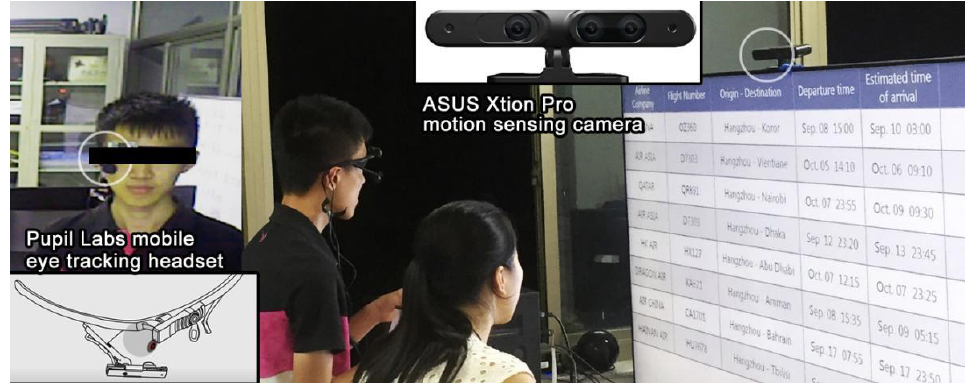
Figure 2. Experimental apparatus and the study scene.